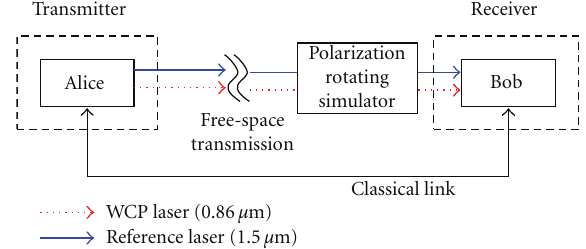
Figure 8: Configuration of the